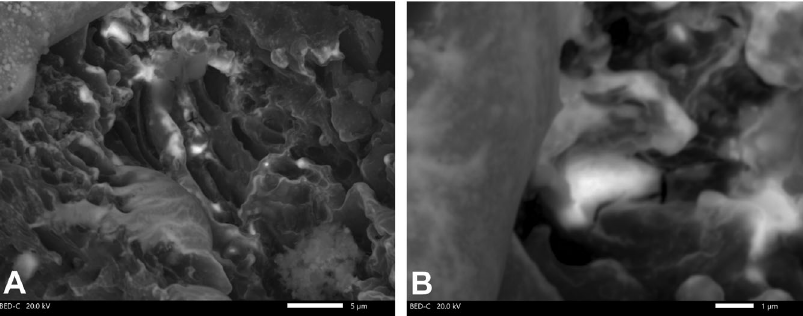
Fig. 7 Scanning electron microscopy of the spots fuel debris smeared on graphite matrix (bright spots in the center, see text for detail). Scale bars: 5 µm in ( A ); 1 µm in ( B ).